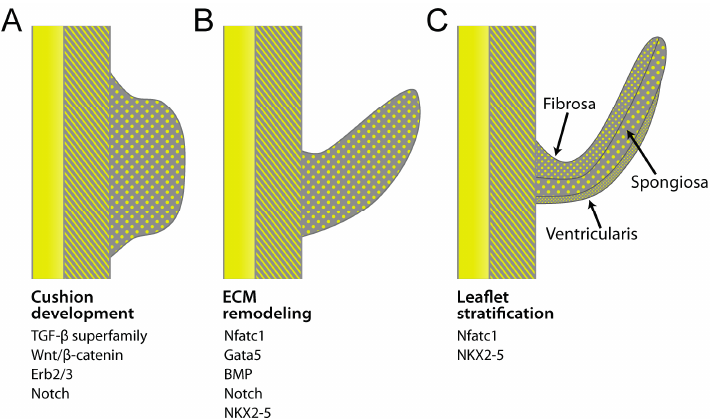
Figure 6. Transcription factors active in aortic valve development. ( A ) Endocardial cushions (purple) form in the cardiac outflow tract. Valve progenitor cells are generated by an endothelial-to-mesenchymal transition (EMT); ( B ) Endocardial cushions elongate to form valve primordia of individual valve leaflets. Extracellular matrix (ECM) remodeling and morphogenesis of the valve leaflets is dependent on Nfatc1 and Gata5; ( C ) ECM of the primordial semilunar valve thins, elongates and stratifies into fibrosa, spongiosa, and ventricularis layers. Modified from